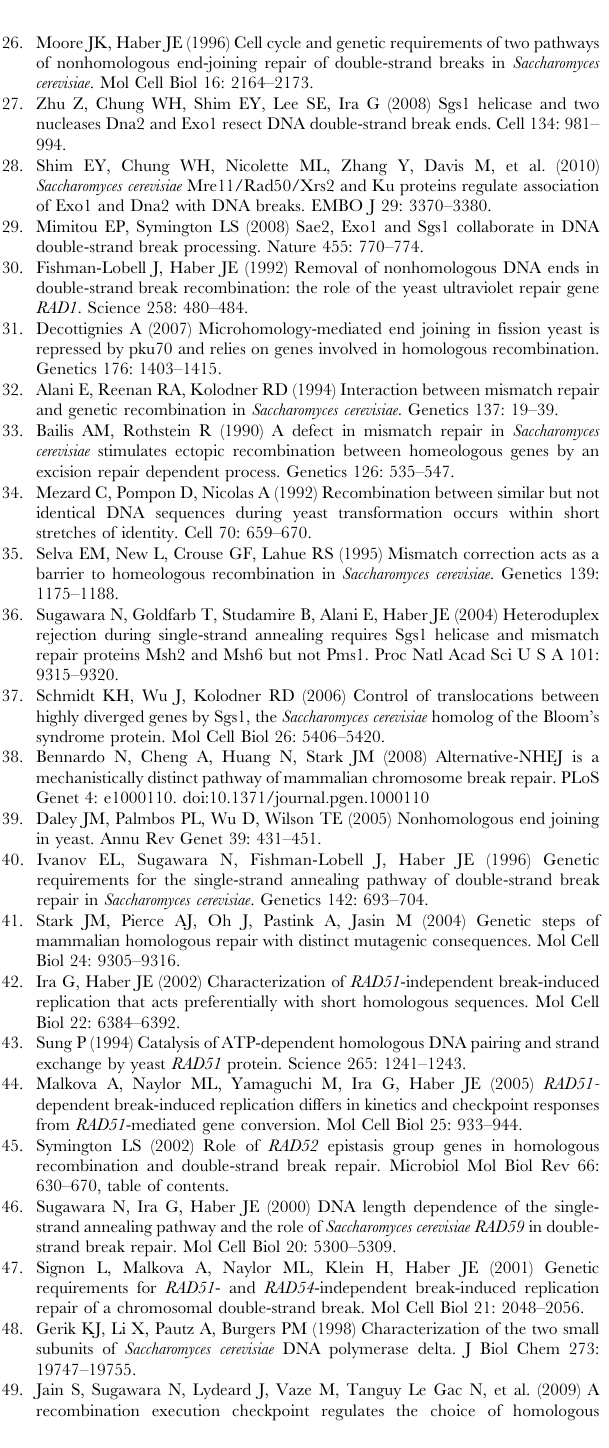
Table S2 Sequencing data. (DOC) Table S3 MHMR chromosomal translocations require resec- tion. Table S4 Melting